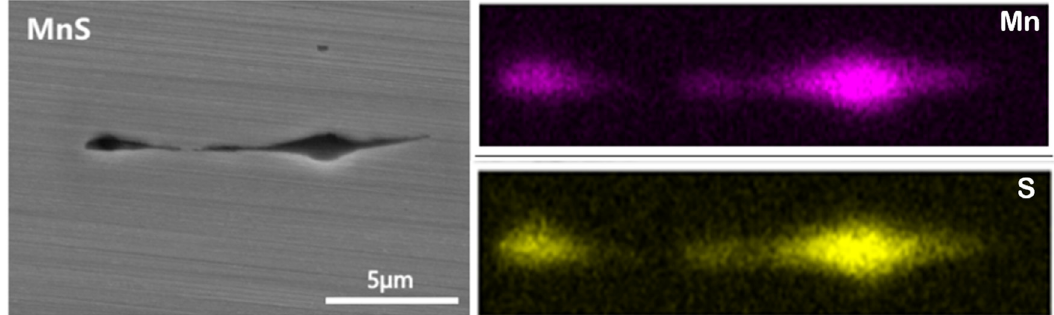
Figure 3: Elemental distribution of MnS inclusions in hot - rolled Y - free